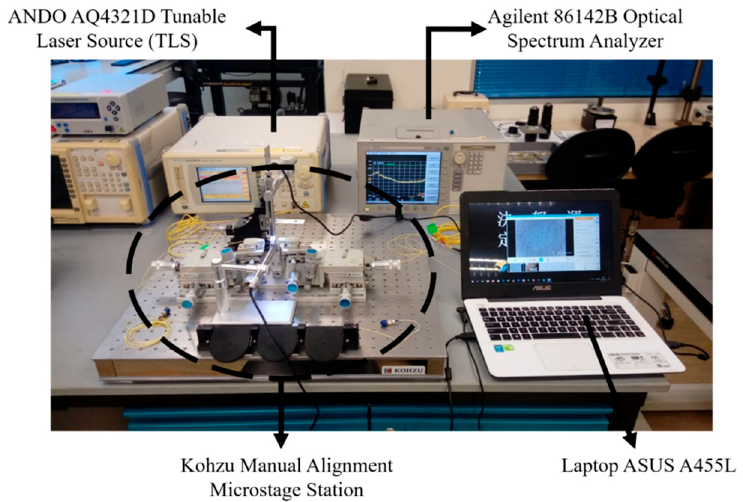
Figure 3. Experimental setup for quality factor characterization in MRR waveguides by through-port power transmission measurements using an optical spectrum analyzer (OSA) and tunable light source (TLS) as a light source.